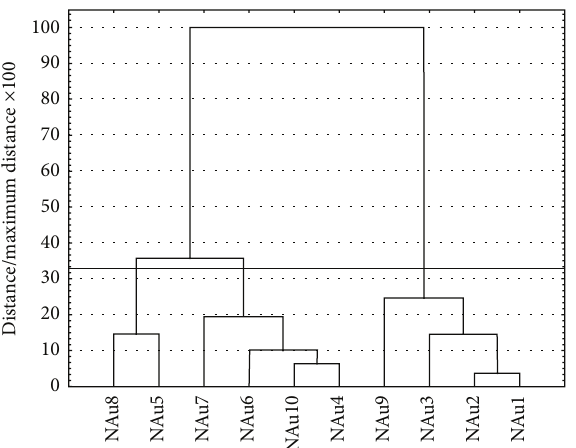
Figure 11: Hierarchical tree showing the assignment of objects (spectra of nanogold) for each cluster.